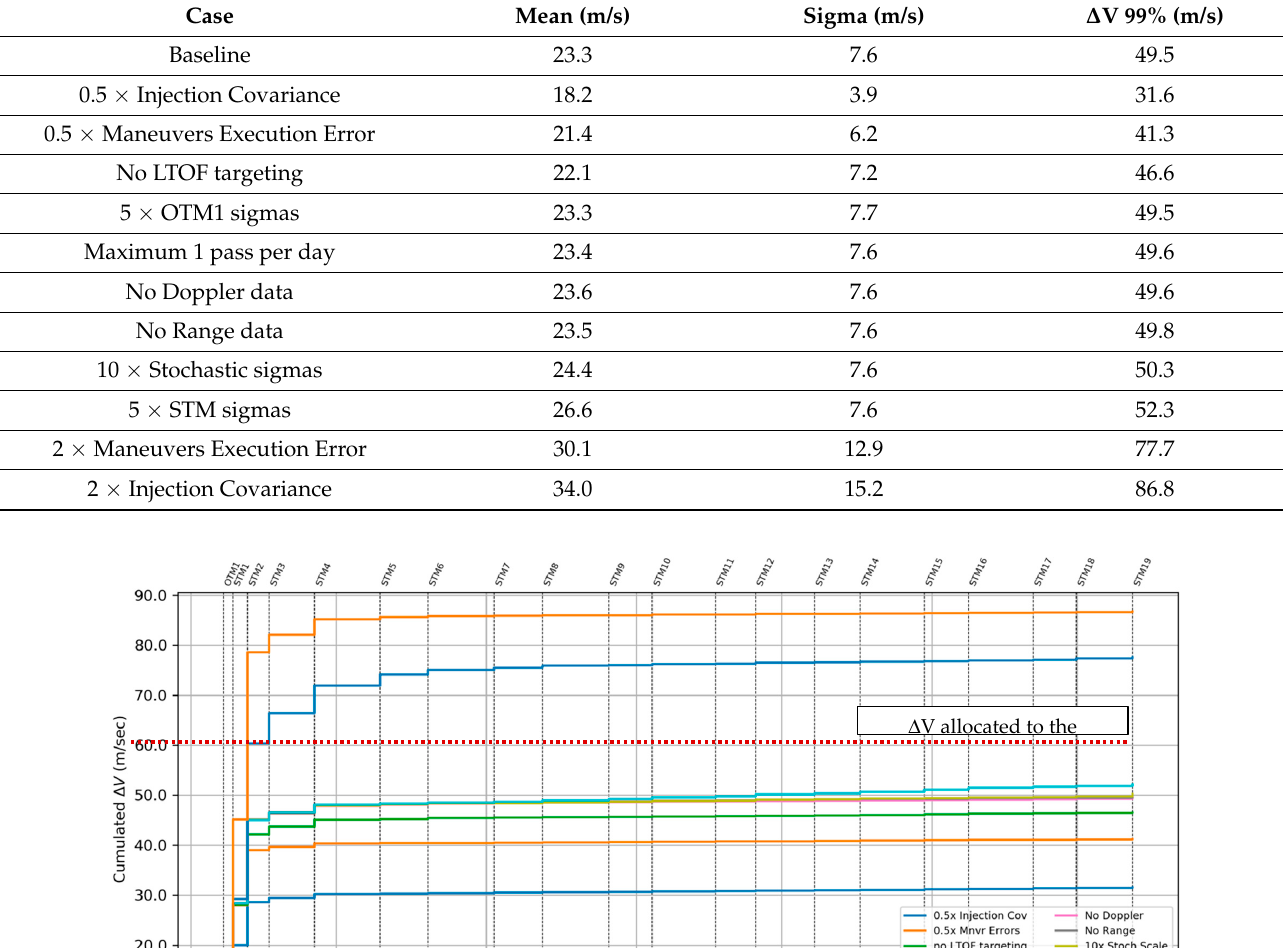
Table 8. Full mission ∆ V statistics for each FPC relevant sensitivity case.